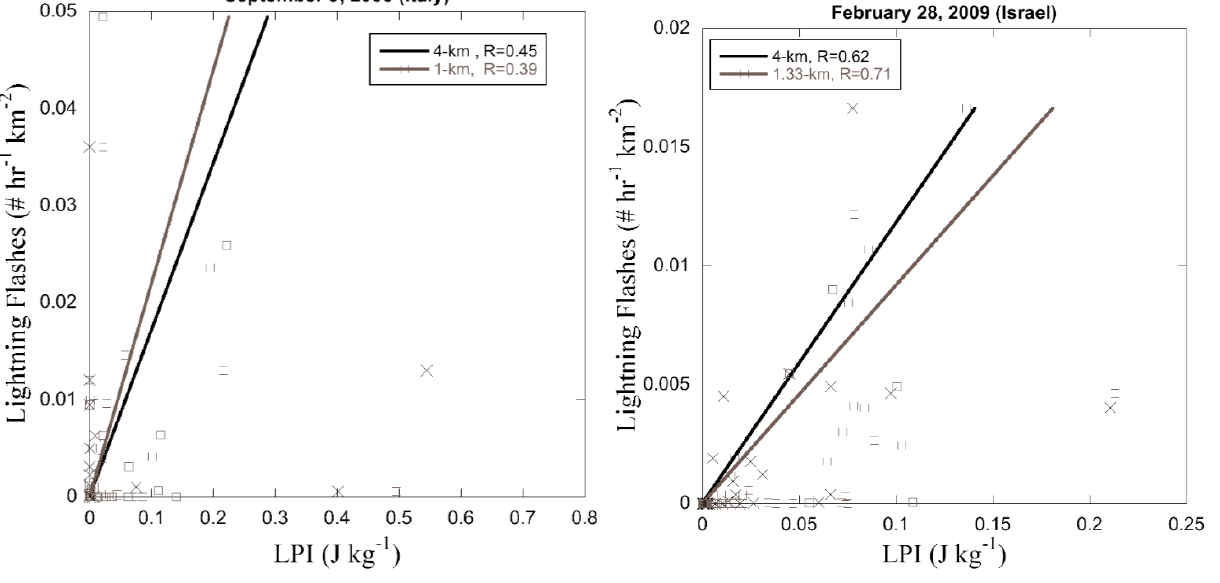
Fig. 2. Correlations between the value of the calculated (time averaged) LPI in 4-km and 1-km grids and the accumulated lightning flash numbers in the respective areas and times for the two case studies Italy (left) and Israel